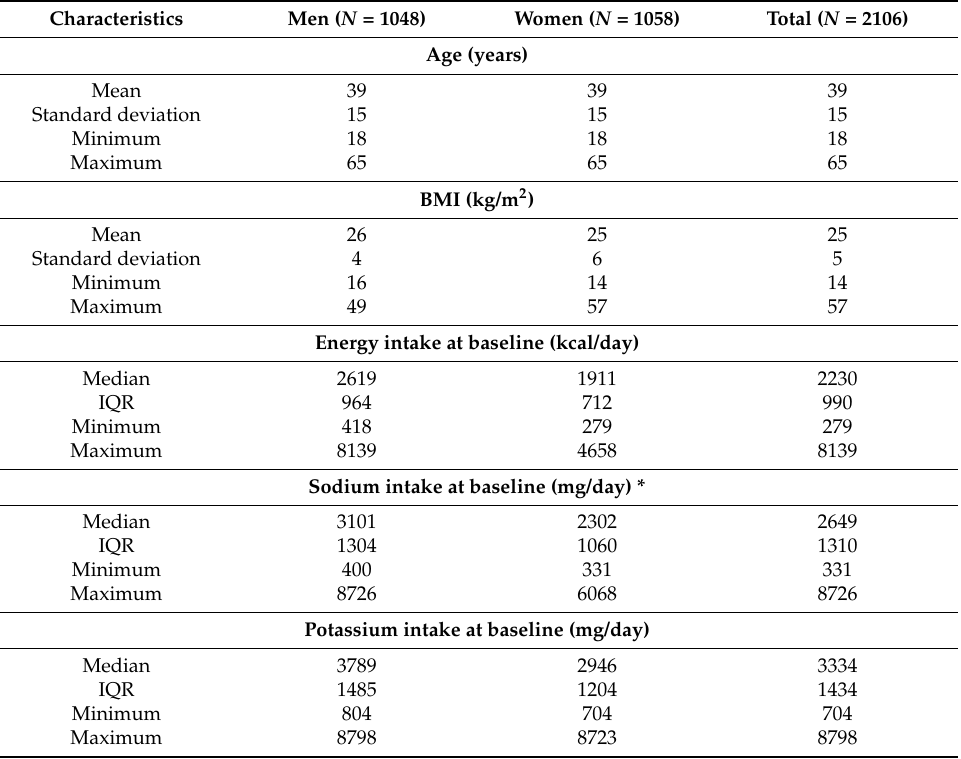
Table 1. Baseline characteristics of